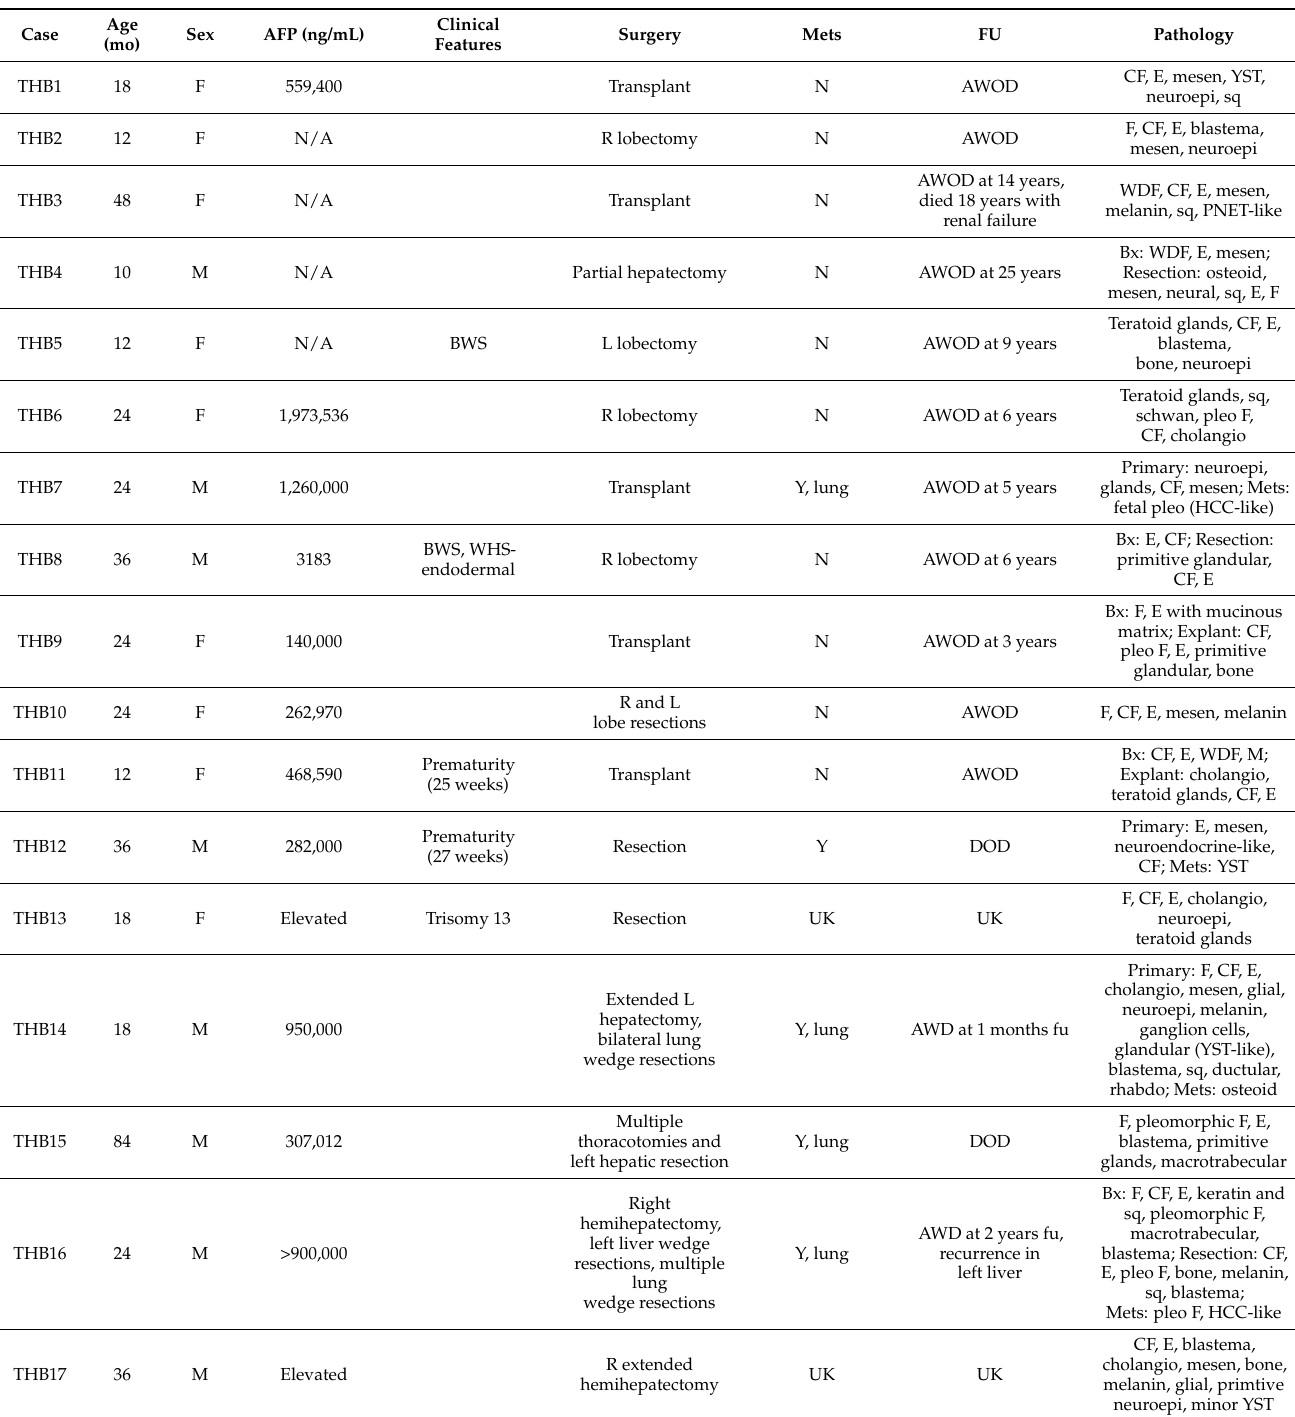
Table 2. Clinicopathologic Features of Teratoid